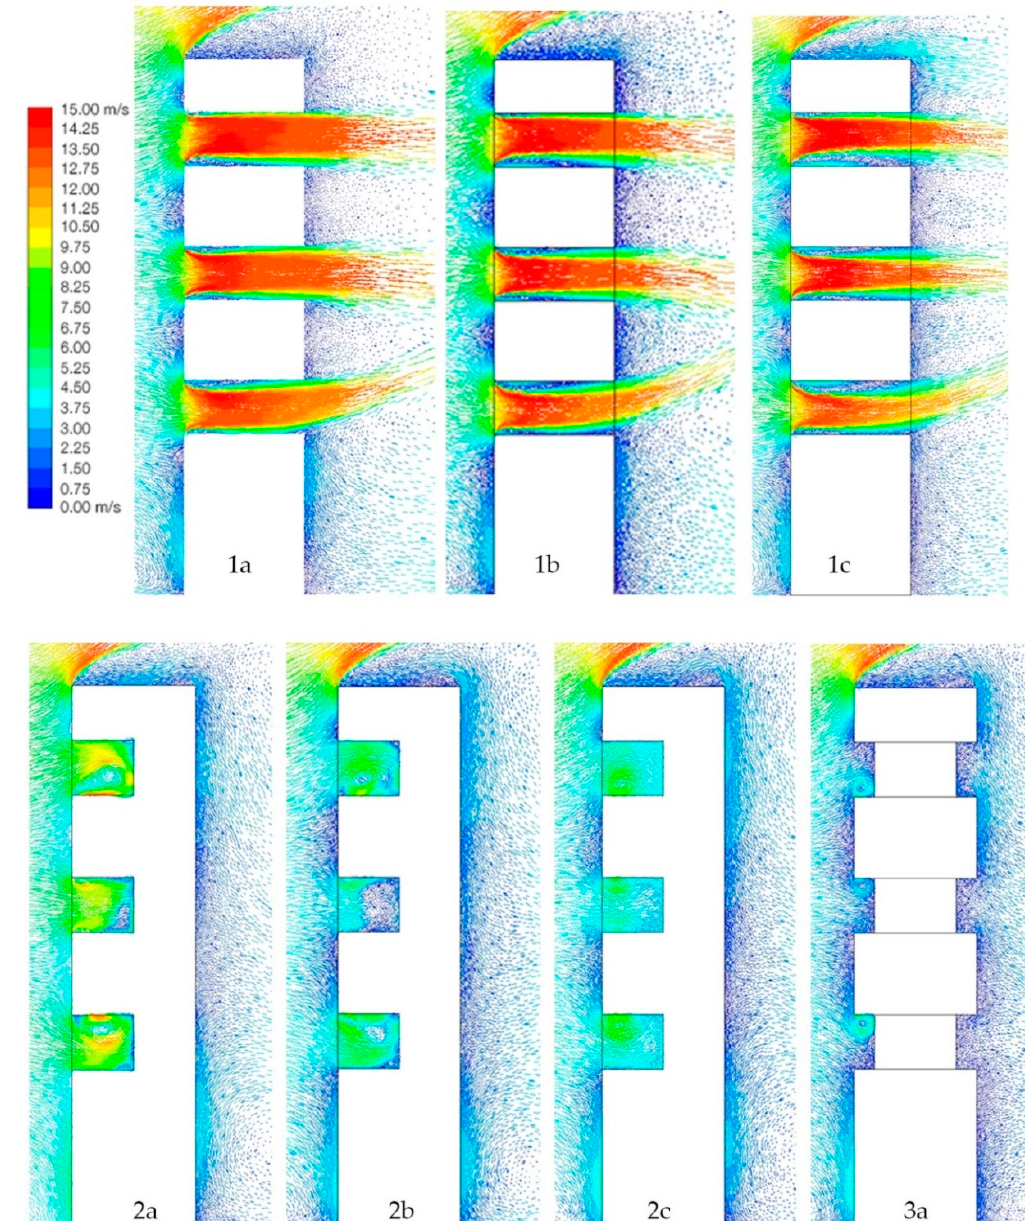
Figure 11. Velocity vectors along the cross-sectional plane; (1a) Central sky garden b/B = 0.4, (1b) Central sky garden b/B = 0.6, (1c) Central sky garden b/B = 0.8, (2a) Corner sky garden b/B = 0.4, (2b) Corner sky garden b/B = 0.6, (2c) Corner sky garden b/B = 0.8, (3a) Periphery sky garden a/A = 0.5.